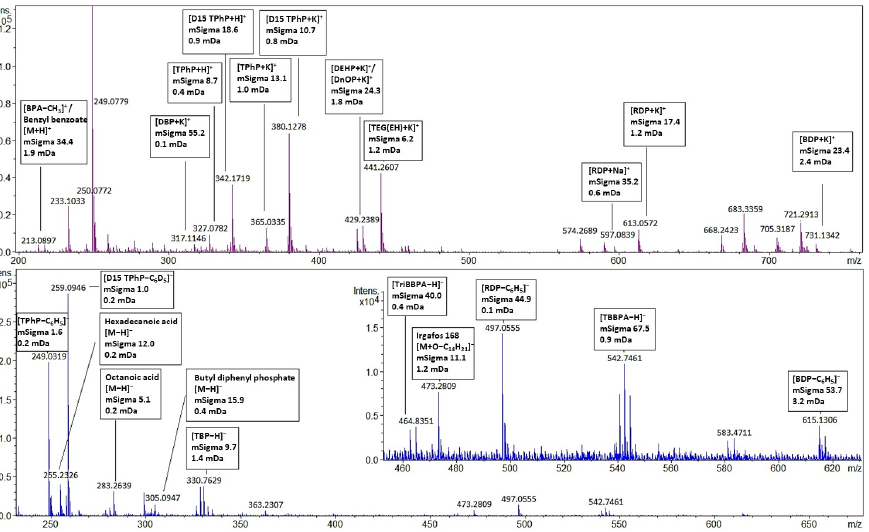
Figure 4. AP-MALDI-qTOF-MS full scan spectrum of sample five with a selected set of annotated compounds. A full set of annotated compounds can be found in Tables S8 and S9) Upper panel: positive ionization mode; lower panel: negative ionization mode. Molecular ions are annotated with their mSigma and mass accuracy (mass error) in mDa. All annotated peaks meet the screening requirements.